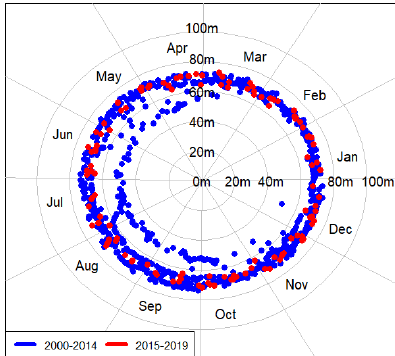
Figure 9. Water height from 2000 to 2019, in polar coordinate system, by month (training set: from 2000 to 2014 and predicted set: from 2015 to